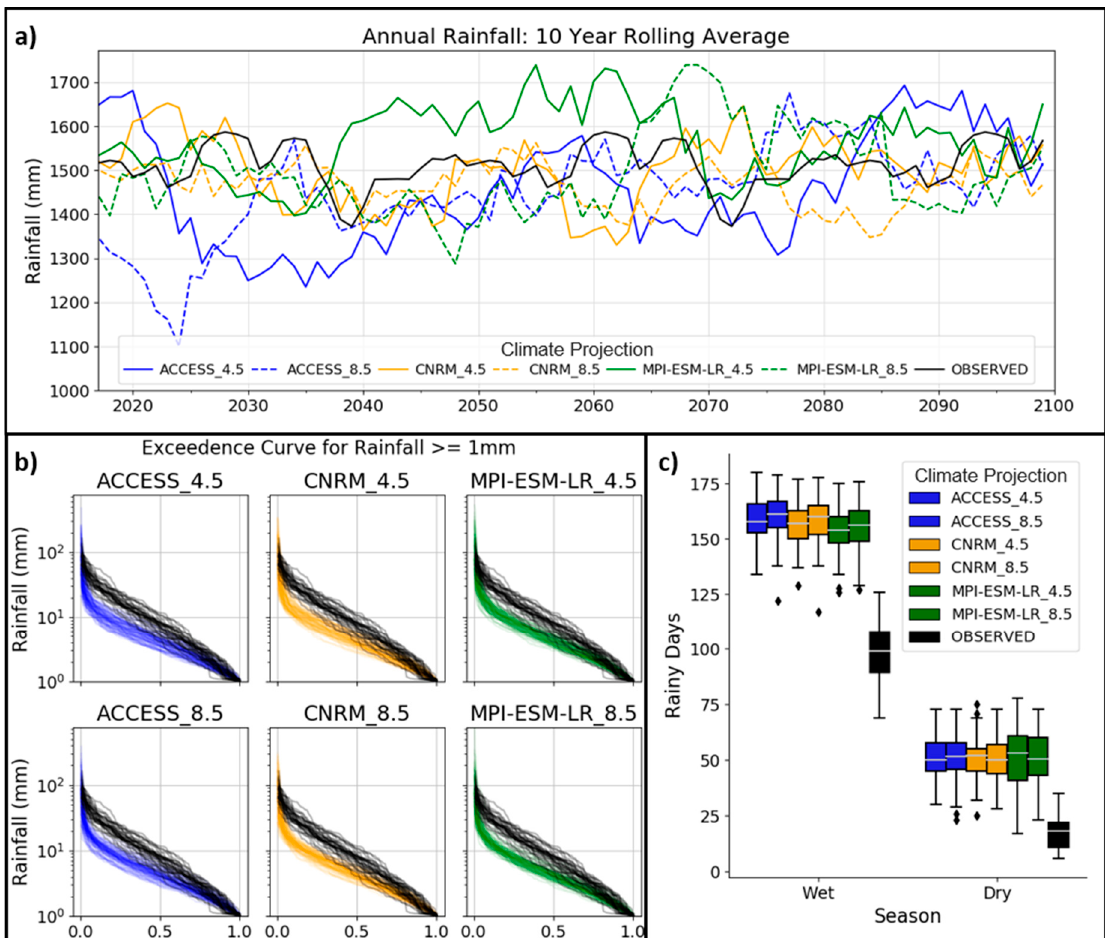
Figure 9. Statistical analysis of downscaled precipitation projections for Catchment 1: ( a ) Rolling ten-year average of total annual precipitation; ( b ) annual exceedance curve for daily precipitation of at least 1 mm for climate scenarios (blue, orange and green) 2019–2099 and historical (black) 1985–2019; ( c ) box plots for number of rainy days per year in the wet and dry season.